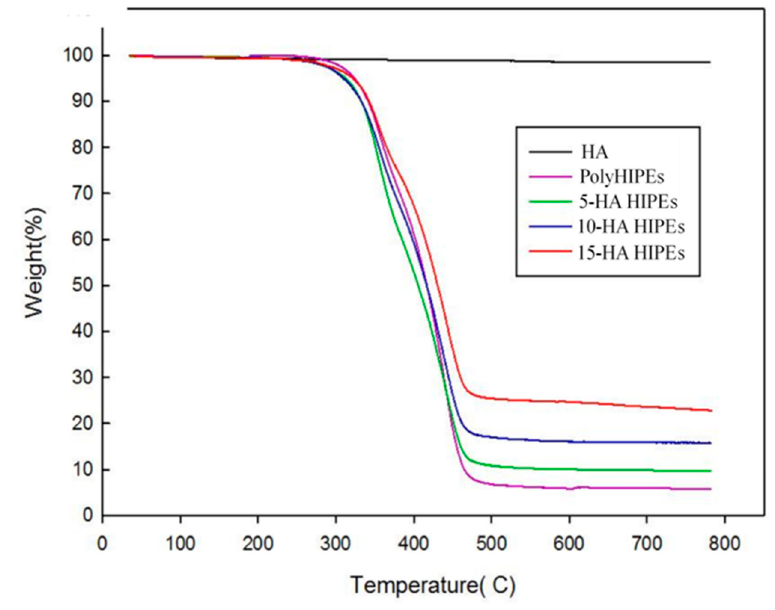
Figure 7. TGA curve of poly(TT/DPEHA)HIPEs with various amount of HA. Table 1. Thermal properties of poly(TT/DPEHA/HA)HIPEs by thermogravimetric analysis.